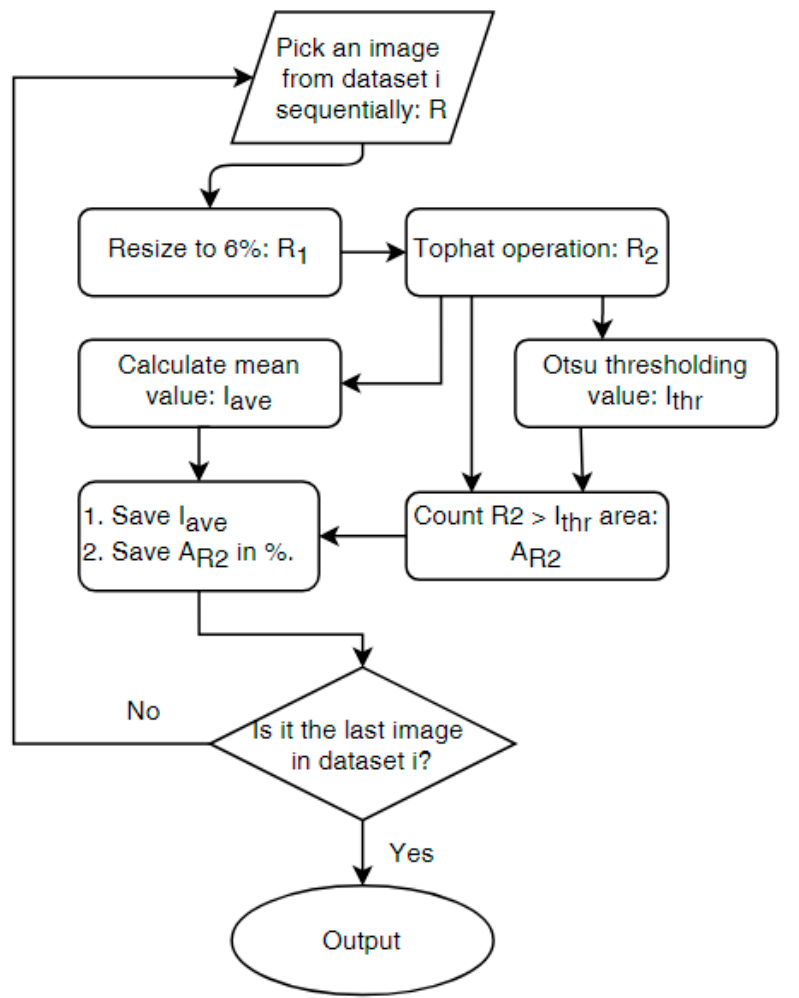
Figure 2. A flowchart of our scheme. There were 10 datasets representing different confluence percentages, from 10 to 100%. This flowchart demonstrates the processing of one dataset.